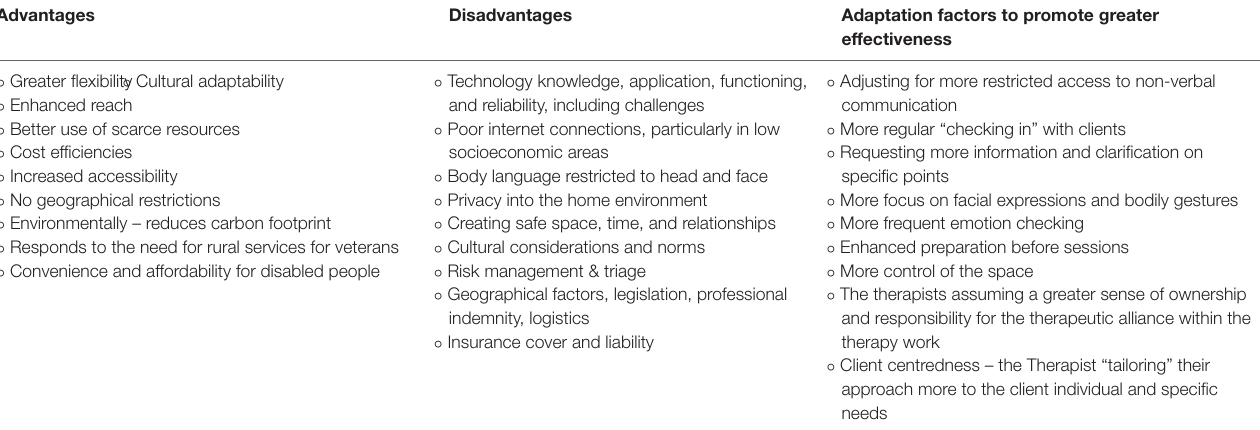
TABLE 1 | Advantages, disadvantages, and adaption factors in VCPs. Advantages